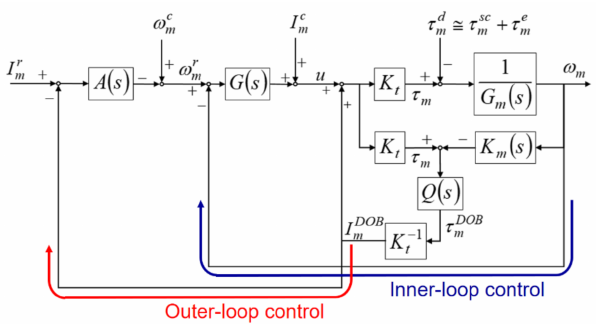
Figure 1. Structure of the spindle speed modulation (SSM)